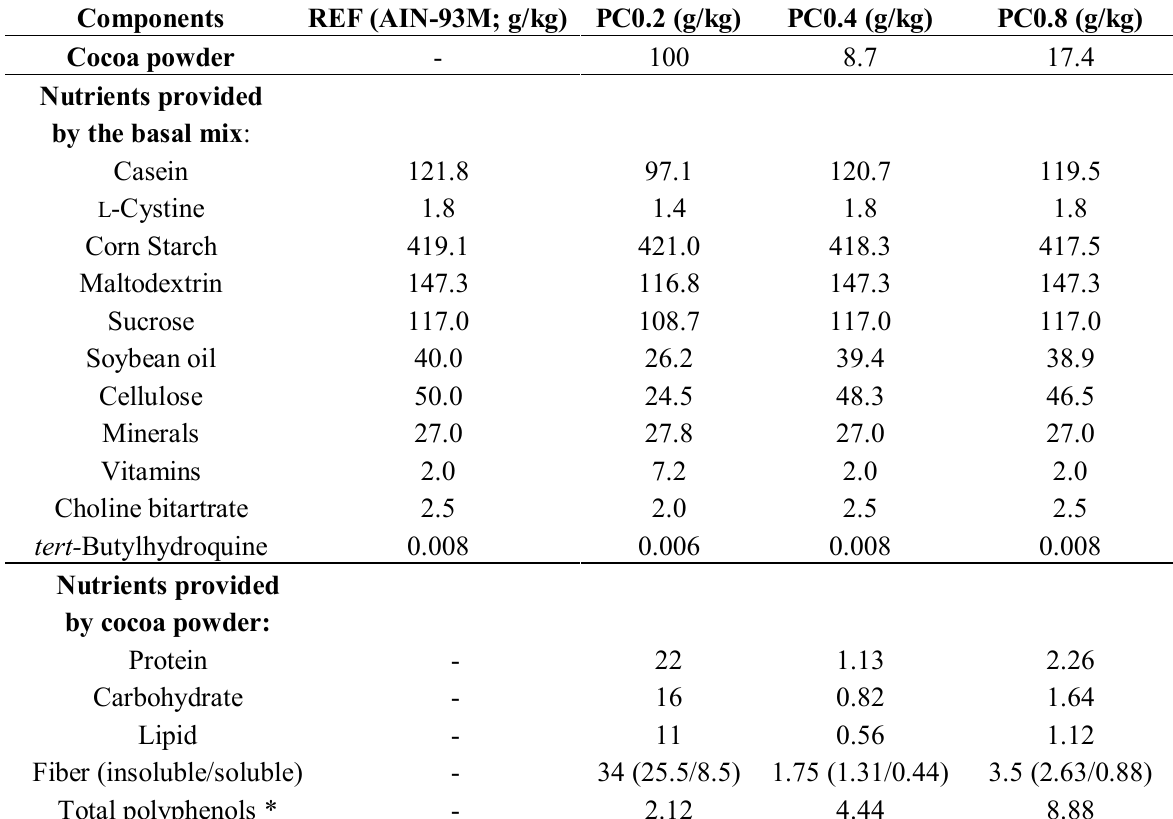
Table 1. Composition of experimental diets (g/kg diet). The three experimental diets provided similar amounts of proteins, lipids and carbohydrates to the reference diet